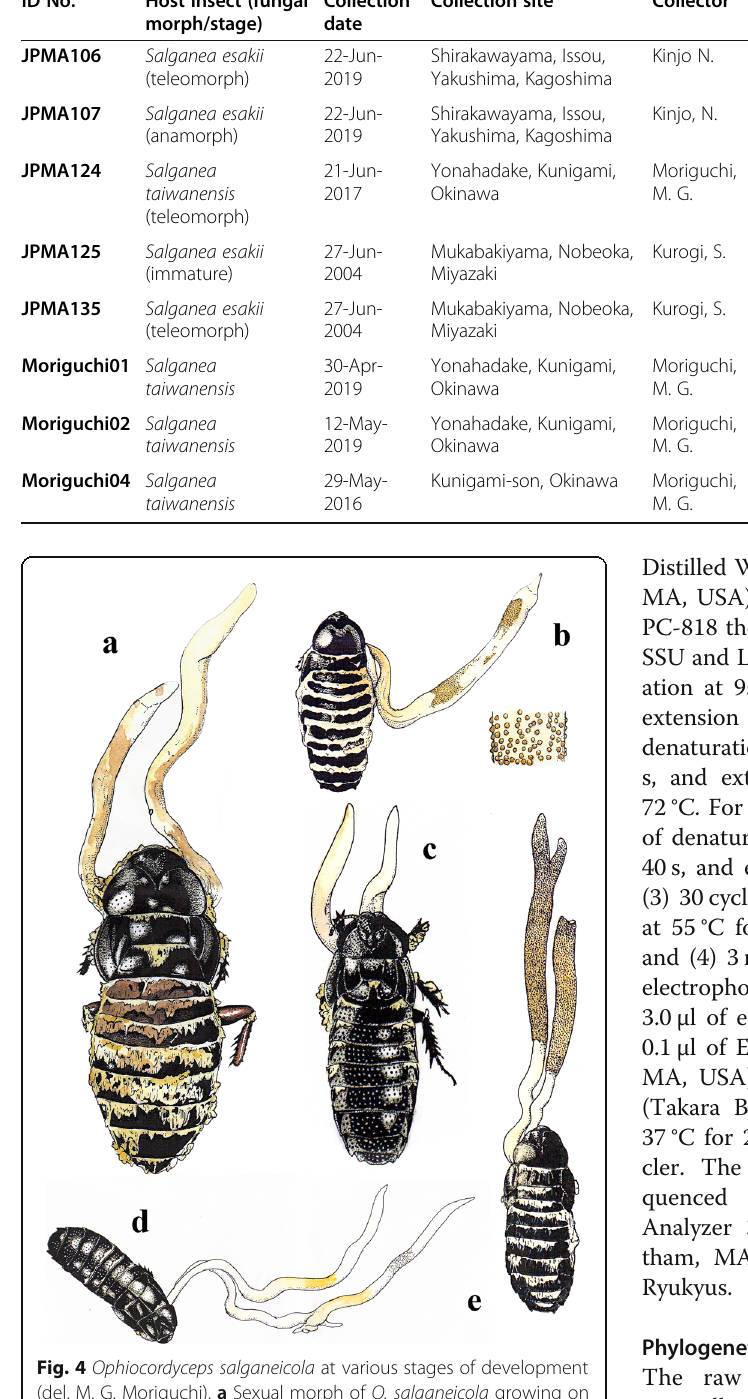
Table 1 Host association, collection date, collection site and GenBank accession numbers for the specimens used in this study ID No.